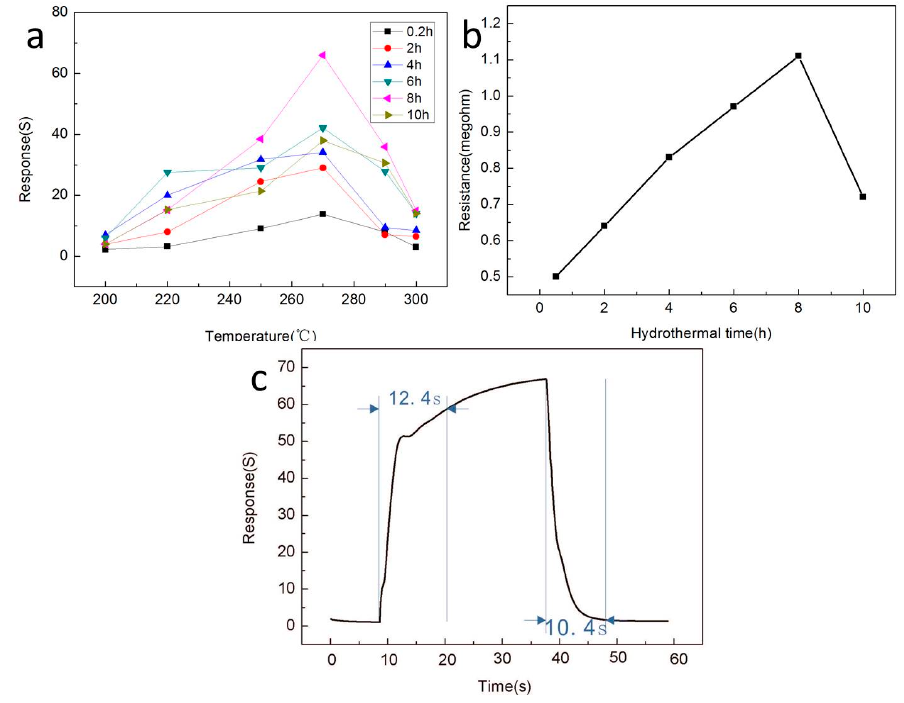
Figure 6. ( a ) The response curves of different sensors to 100 ppm ethanol gas at different operating temperatures; ( b ) Resistance values in air of the nanostructured sensors prepared under different hydrothermal action times; ( c ) Response curve of the In 2 O 3 -8 h sensor to 100 ppm ethanol at the optimum operating temperature of 270 °C. Table 1. The gas sensitivity of various ethanol sensing materials to ethanol in current studies.